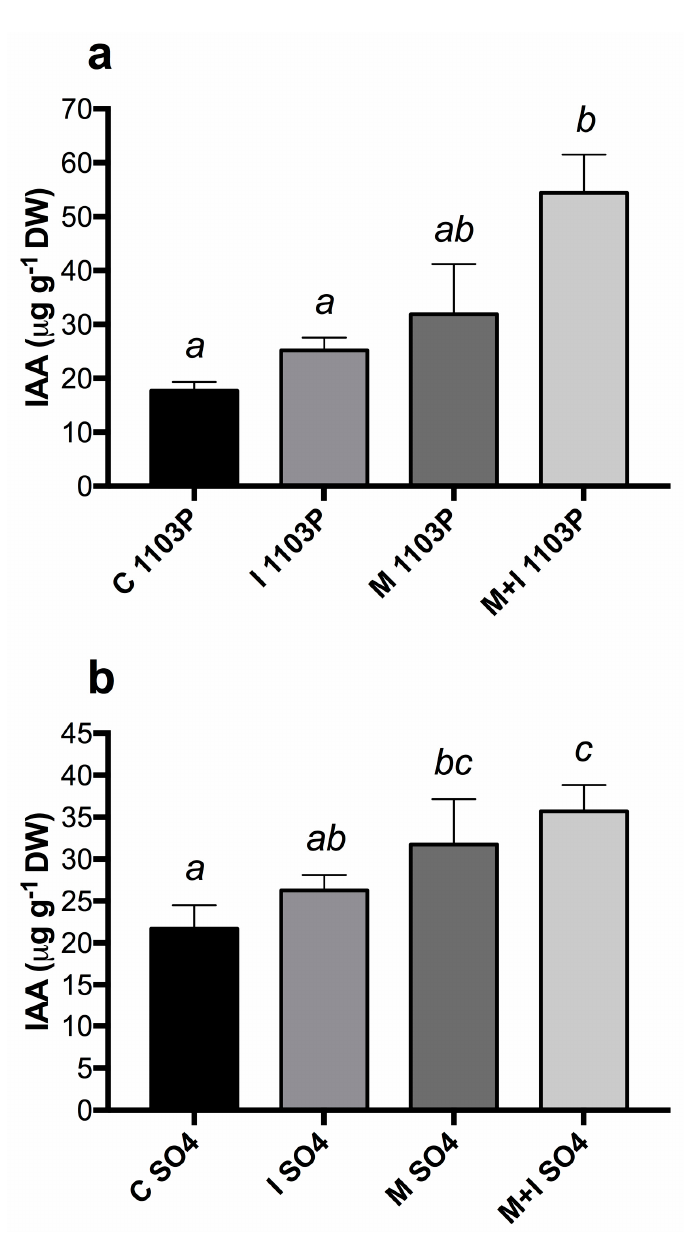
Figure 5. Analysis of the endogenous leaf IAA concentration. ( a ) IAA concentration in leaves of ‘Glera’ plants grafted onto 1103P and SO4 ( b ) rootstock genotypes. Data are expressed as mean ± SD ( n = 10) of randomly selected plants over 2020 and 2021 seasons. Different lowercase letters above the bars indicate significant differences according to Tukey’s HSD test ( p < 0.05). C, control plants; I, Inducer-treated plants; M, AMF mixed inoculum-treated plants; M+I AMF mixed inoculum + Inducer-treated plants. Looking at the concentration of the defense-related stilbenoids (Figures 6 and 7), t - resveratrol did not differ significantly among treatments in both 1103P and SO4 grafted plants (Figures 6a and 7a). Contrariwise, viniferin was significantly more accumulated in M and M+I 1103P leaves with respect to C (Figure 6b), while this metabolite did not differ among treatments in SO4 samples (Figure 7b) further confirming the AMF-mediated balancing effect in 1103P